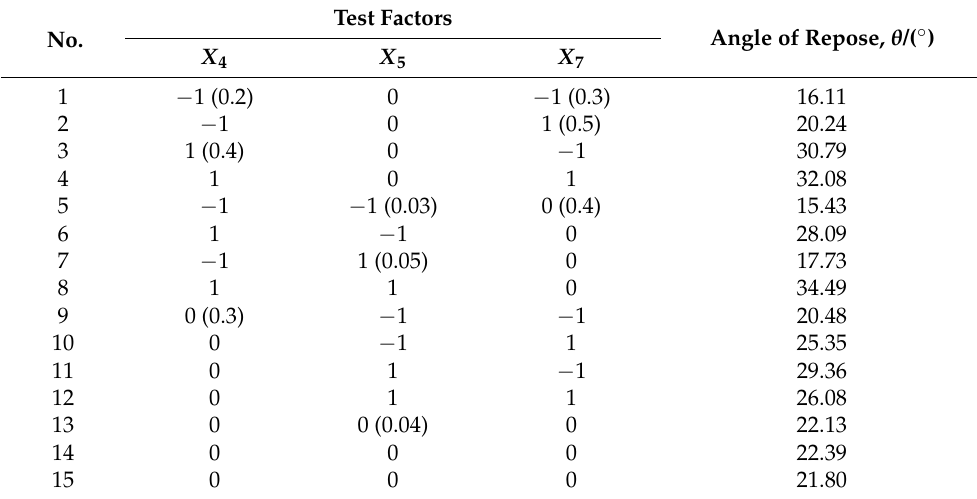
Table 8. Box-Behnken test design scheme and